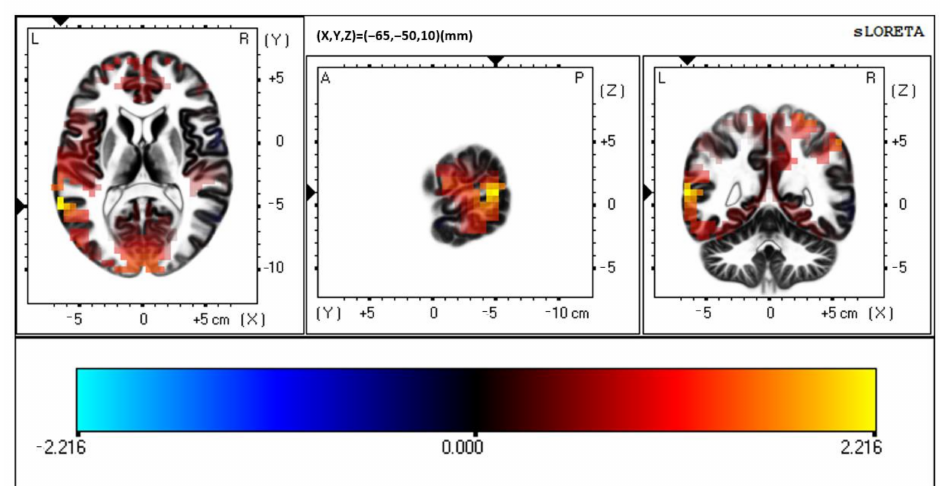
Figure 5. sLORETA visual unisensory response, ADHD vs. Controls. Slice Viewer highlighting region of greatest neural activity difference between controls and those with ADHD. Views, from left to right, include a transverse, sagittal, and coronal cross-sectional area. Control > ADHD activity at BA 22, left-hemispheric temporal lobe.